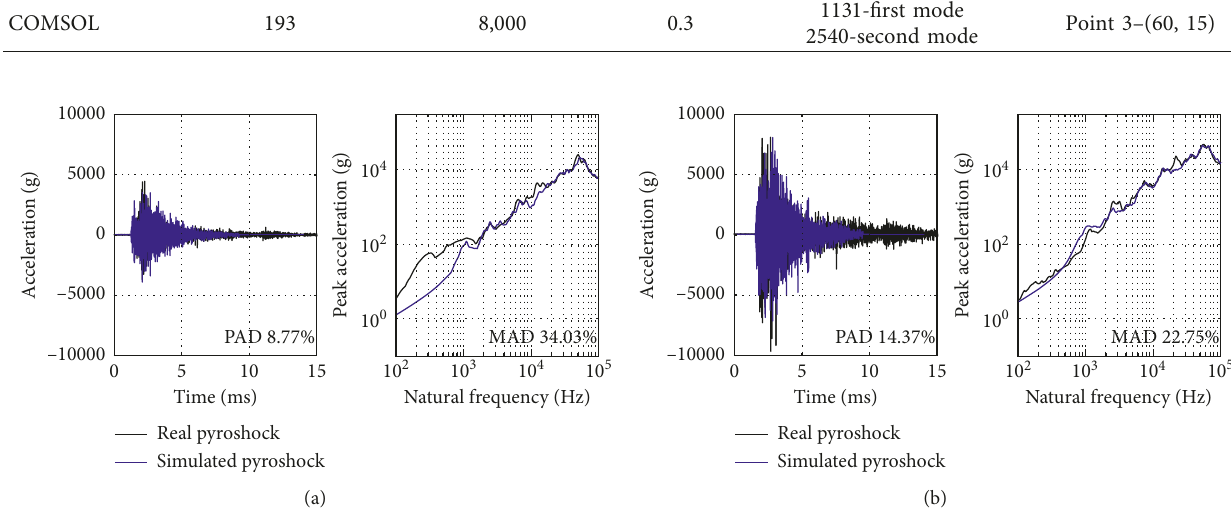
Table 3: Modal analysis condition for pyroshock on the open-box-type tension joint. FEA software